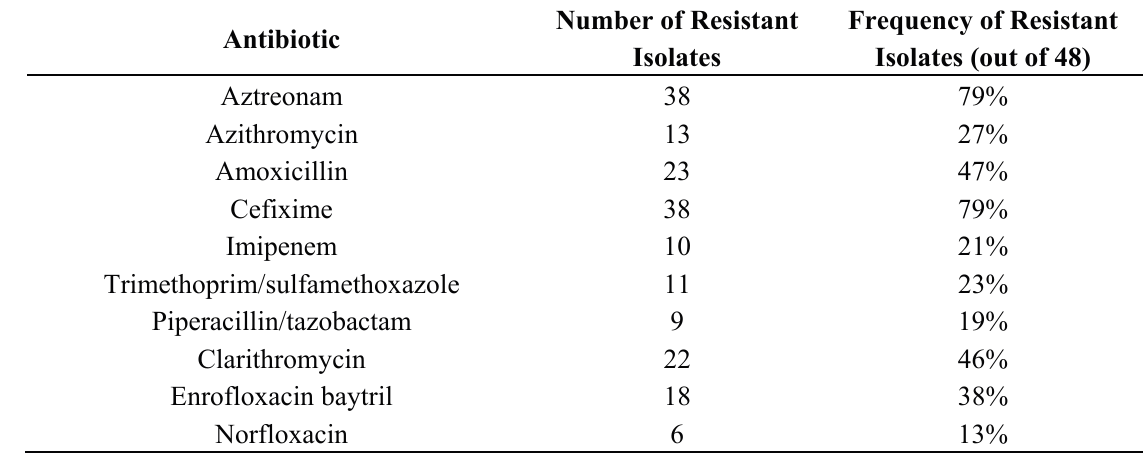
Table 2. Antibiotic sensitivity of bacterial